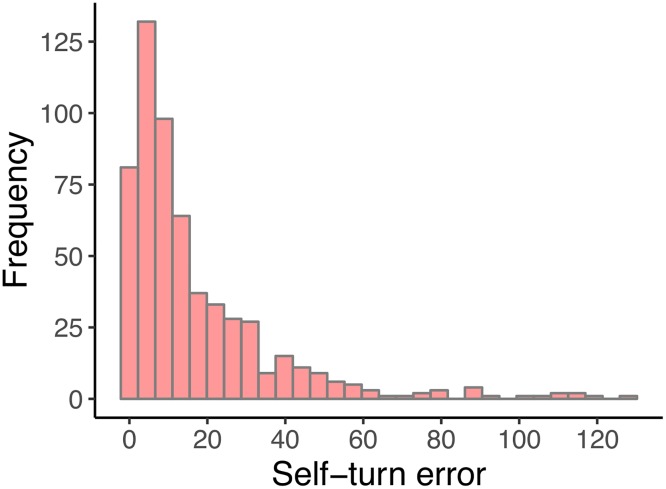
Frequencies of the observed self-turn errors.(nparticipants = 49; nobservations = 578).